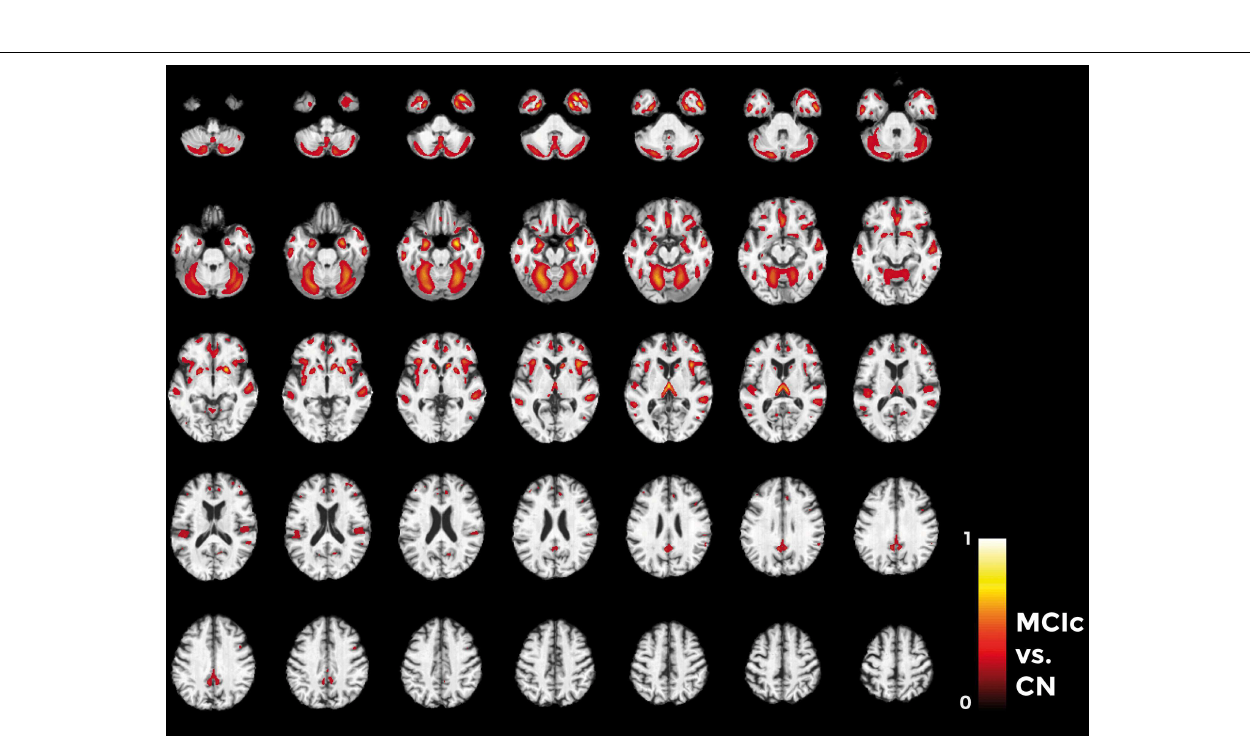
FIGURE 11 | Voxel-based pattern distribution map (axial view) for the classification between MCIc and CN. Voxel-based pattern distribution (normalized to a range between 0 and 1) is expressed according to the color scale (threshold = 45%) and superimposed on a standard stereotactic brain for spatial localization.